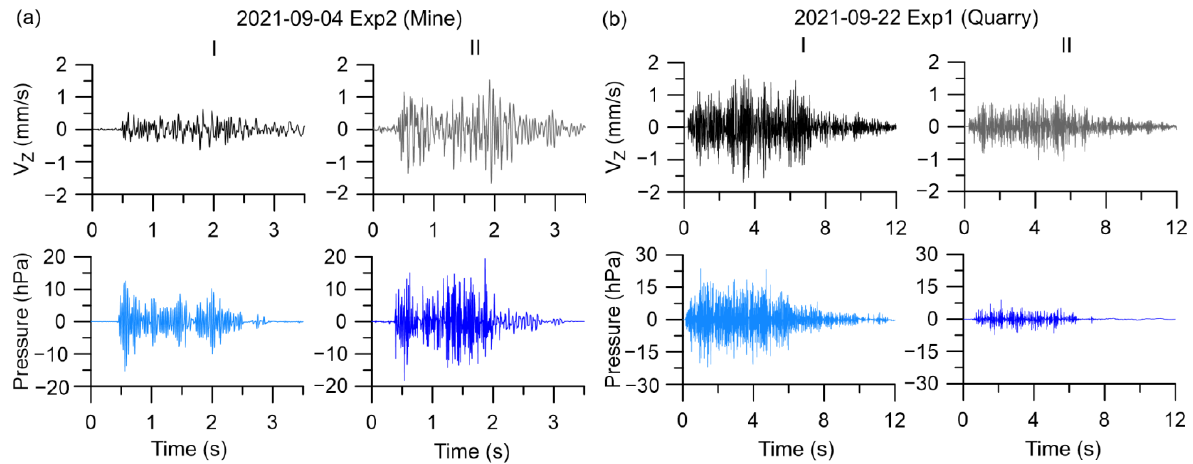
Figure 7. Seismograms (upper row) and pore pressure variations in the system reservoir well (lower row) corresponding to the explosions in the mine on September 4, 2021 (to the left) and in the quarry on September 22, 2021 (to the right) recorded in point I and point II.